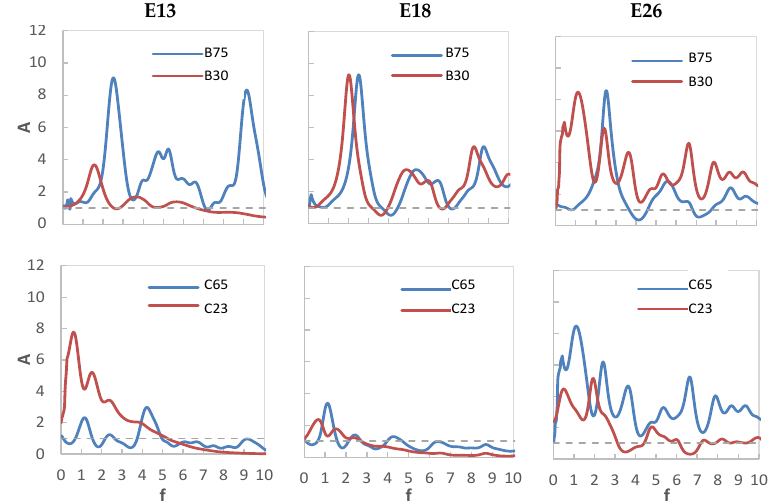
Figure 7. Comparison between the amplification functions obtained for the SS alignment.